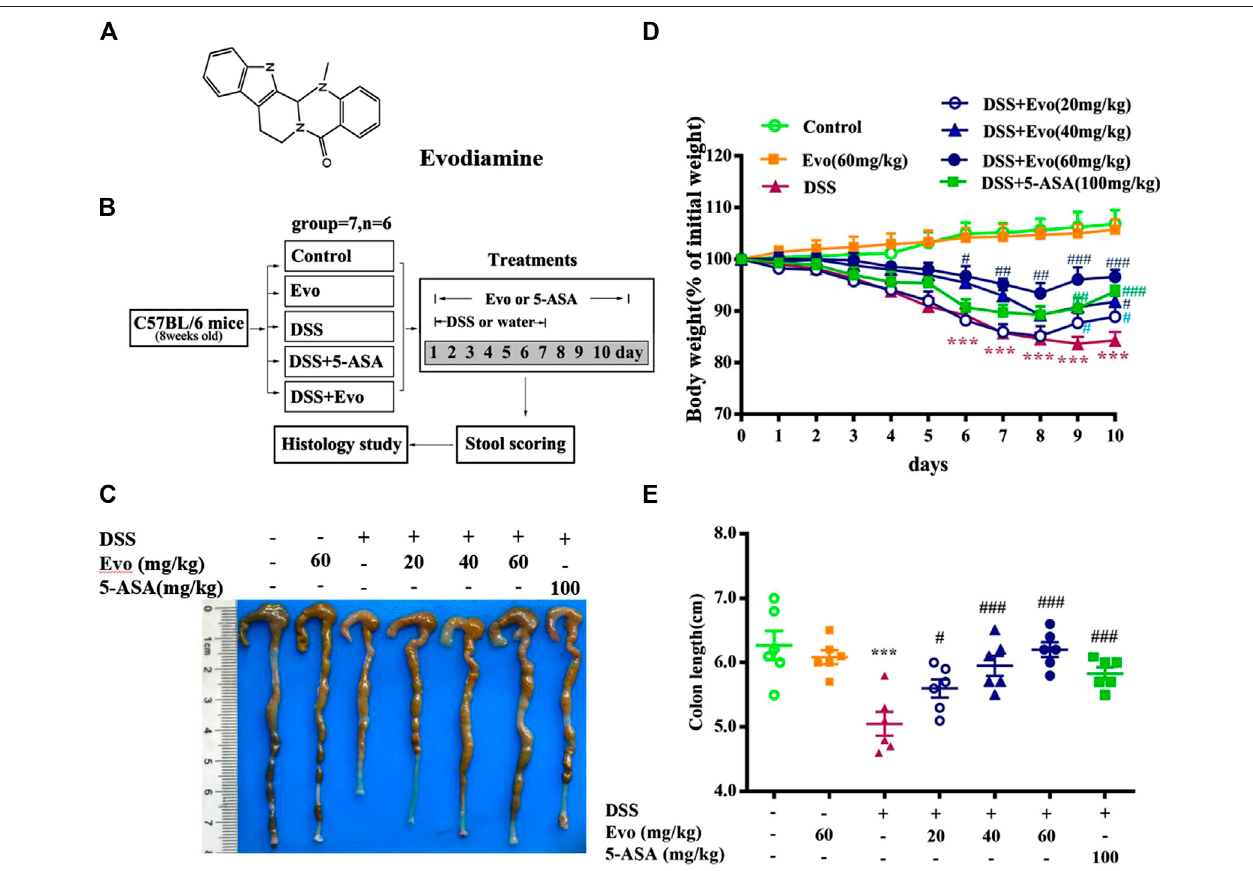
FIGURE1| EvodiamineattenuatedDSS-inducedexperimentalulcerativecolitisinjuryinmice.Ulcerativecolitiswasinducedby3%DSSfor7 daysandreplacedby waterforsubsequent3 days.Evodiamine and5-ASAwereadministered oncedailyfor10 daysbyoralgavage,respectively. (A) Chemicalstructure ofevodiamine. (B) A scheme of experimental design in vivo . (C) Macroscopic appearance of colon. (D) Body weight. (E) Colons length. Data are presented as mean ± SE ( n (cid:2) 6 for each group). * p < 0.05, ** p < 0.01, and *** p < 0.001 compared with the control, # p < 0.05, ## p < 0.01, and ### p < 0.001 compared with the DSS group.